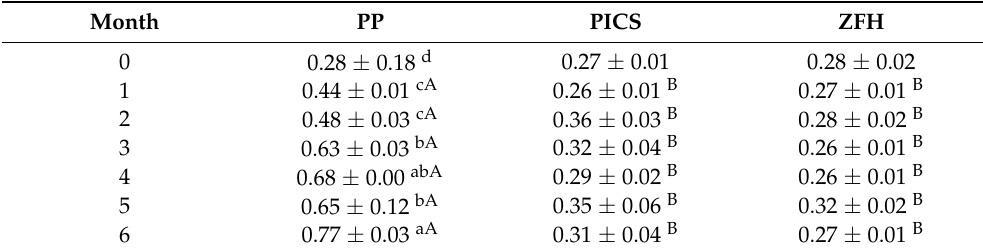
Table 6. Mean ( ± SE) levels of fumonisin (ppm) in maize from Polypropylene (PP), Purdue Improved Crop Storage (PICS), and ZeroFly ® Hermetic (ZFH) bags sampled during the months of October